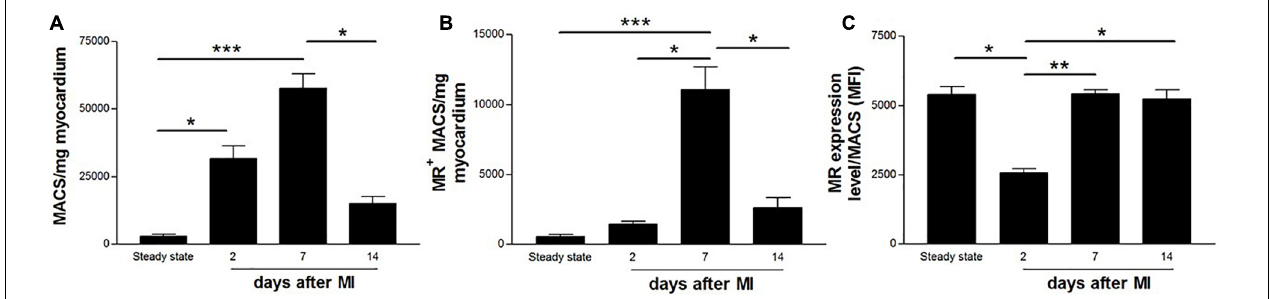
FIGURE 2 | Flow cytometric quantification of (A) total number of macrophages, (B) MR + macrophages, and (C) MR expression level on cardiac macrophages in non-infarcted (steady state) and infarcted (2, 7, and 14 days after coronary ligation) wildtype mice hearts. Data are derived from n = 5-7 mice per time point.